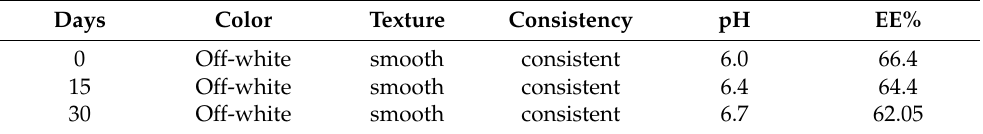
Table 3. The effects of storage conditions on the physical and chemical properties of the formulation of FEO–PLGANPs gel at ambient temperature. Color